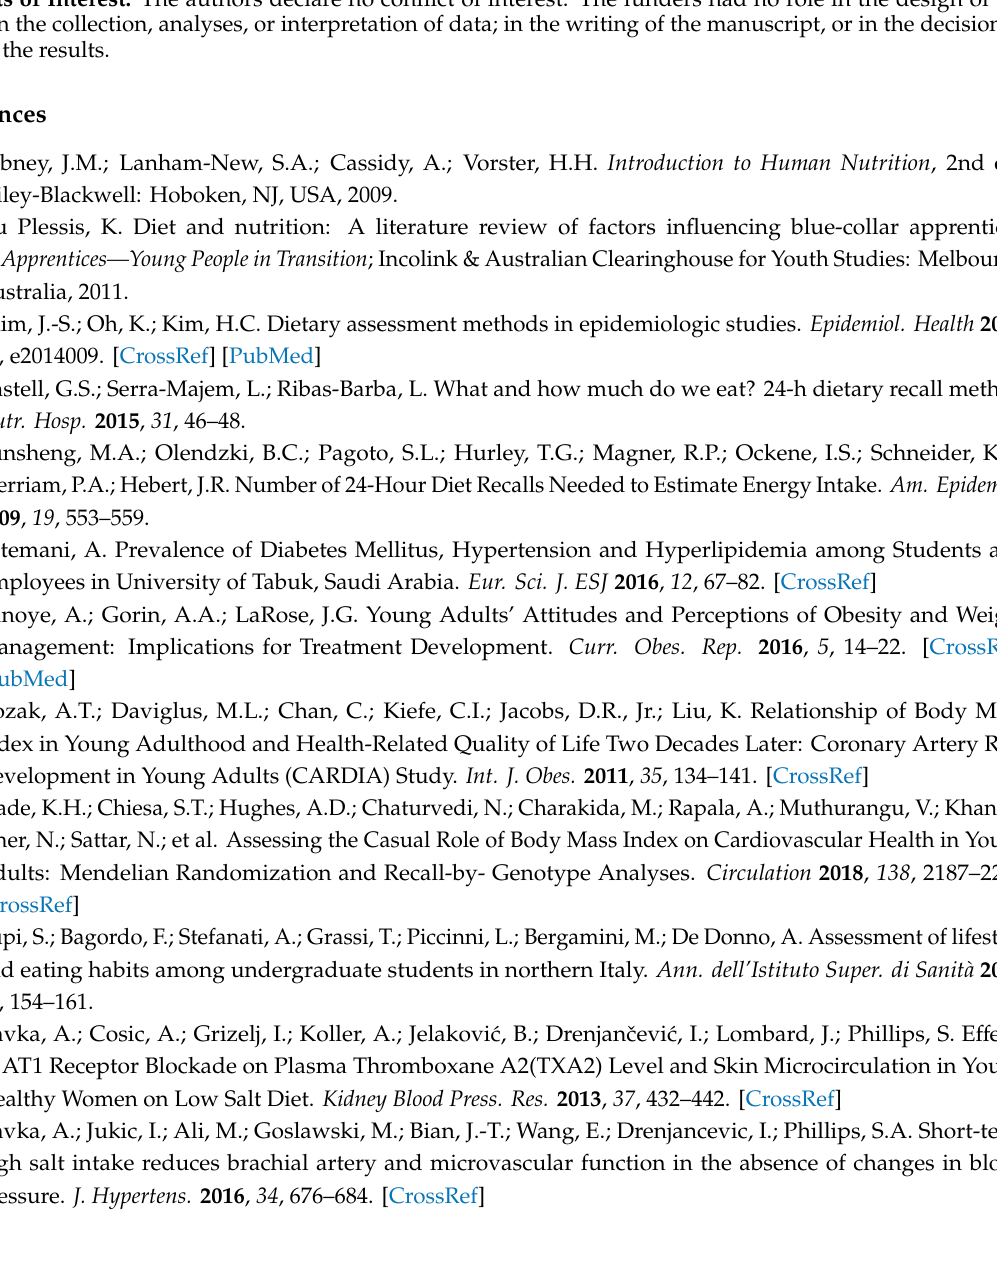
Table S1: Dietary Assessment